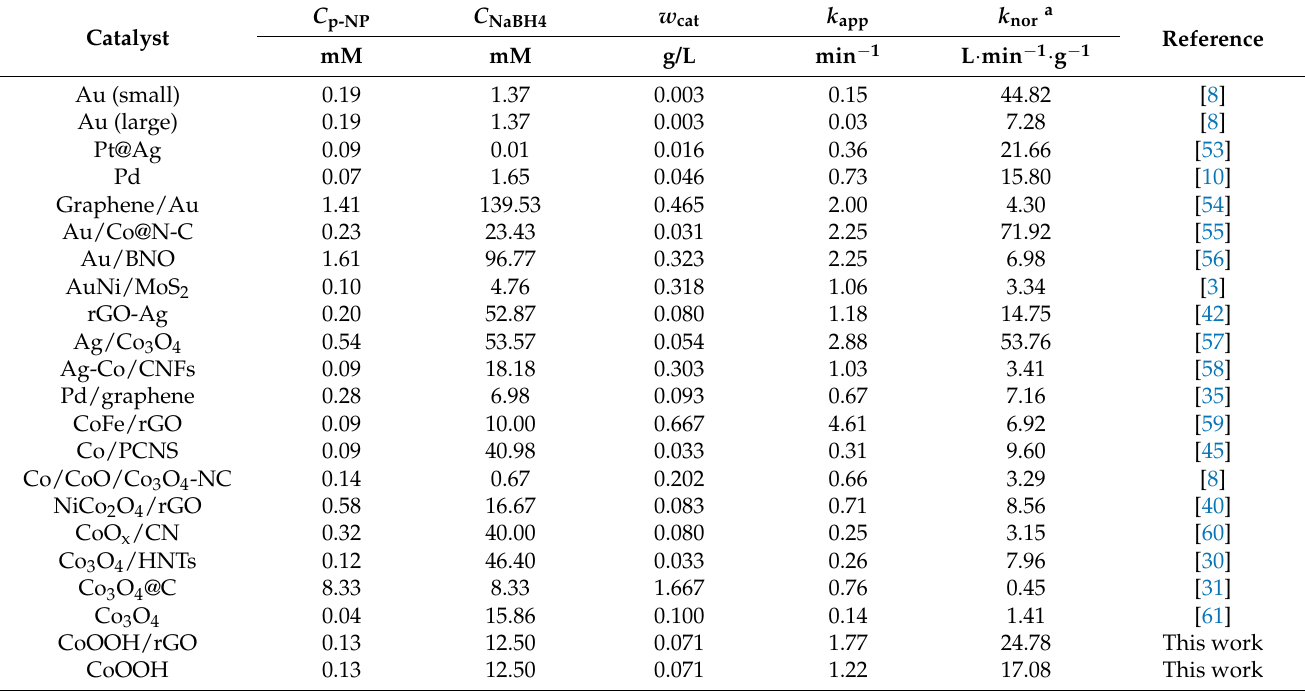
Table 3. The mass-normalized rate constants of various